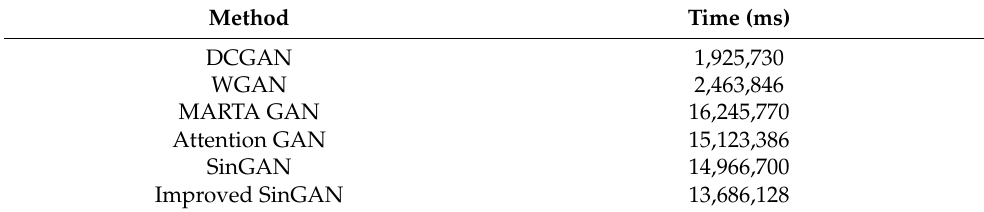
Table 1. Computaion time of different methods.